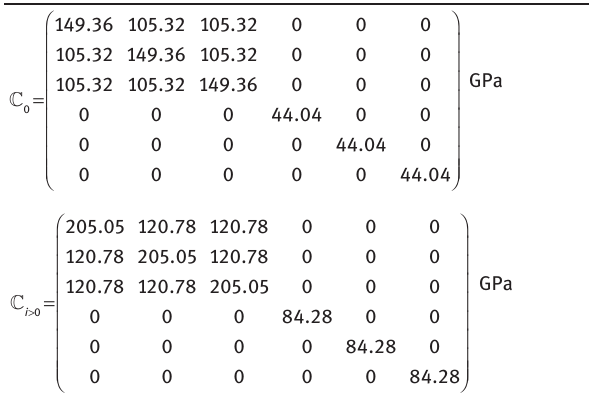
Table 2 Expectation values for the elastic constants for austenite and martensite in NiTi, based on the experiments in [18] and